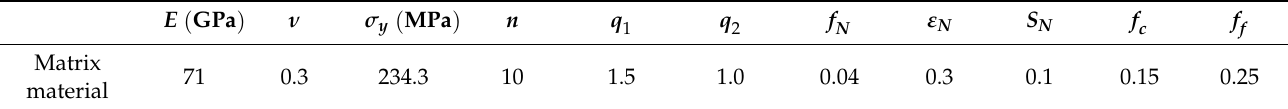
Table 1. Material properties for the sheet metal.